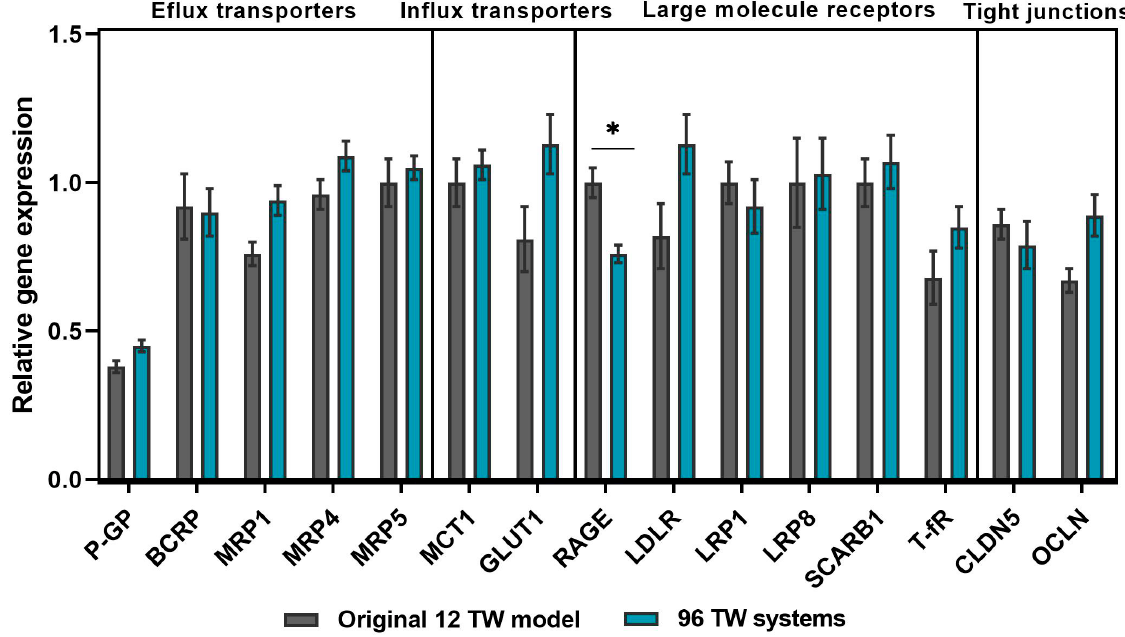
Figure 4. Gene expression analysis by RT-qPCR. Profile study comparison between the original 12 TW model (grey bars) and miniaturized 96 TW system (blue bars) of the efflux and influx transporters, large-molecule receptors and tight junctions. Samples were n = 9 in N = 3 (except for LRP1: n = 6 and N = 2). Relative normalized expression with RPLP0. Mean ± SEM. Multiple t -test showed no significant differences for: P-gP ( p = 0.261), BCRP ( p = 0.988), MRP1 ( p = 0.126), MRP4 ( p = 0.548), MRP5 ( p = 0.988), MCT1 ( p = 0.988), GLUT1 ( p = 0.410), LDLR ( p = 0.422), T-fR ( p = 0.988), LRP1 ( p = 0.988), LRP8 ( p = 0.988), SCARB1 ( p = 0.732), CLDN5 ( p = 0.988) and OCLN ( p = 0.176), except for RAGE gene expression (* p = 0.0120).